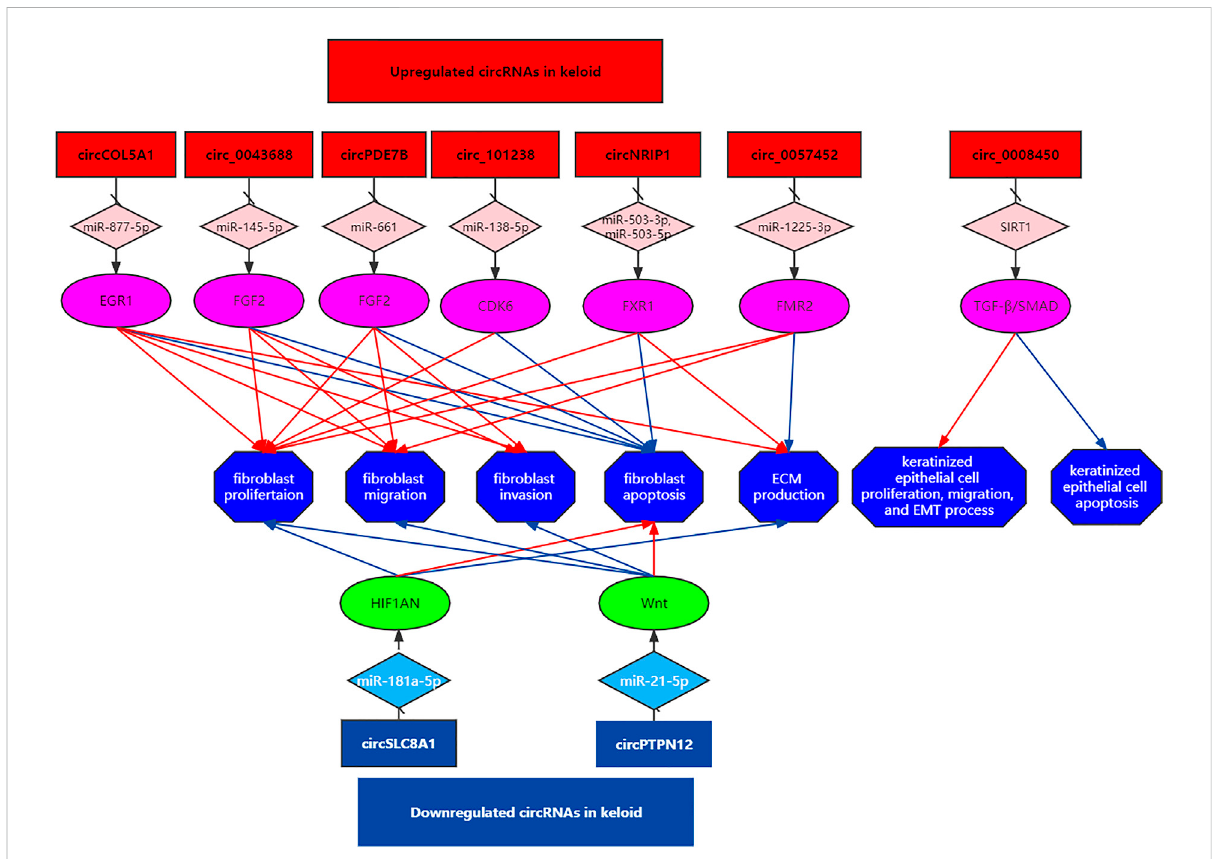
CircRNAs regulated gene expression via sponging miRNAs and played crucial roles in keloid